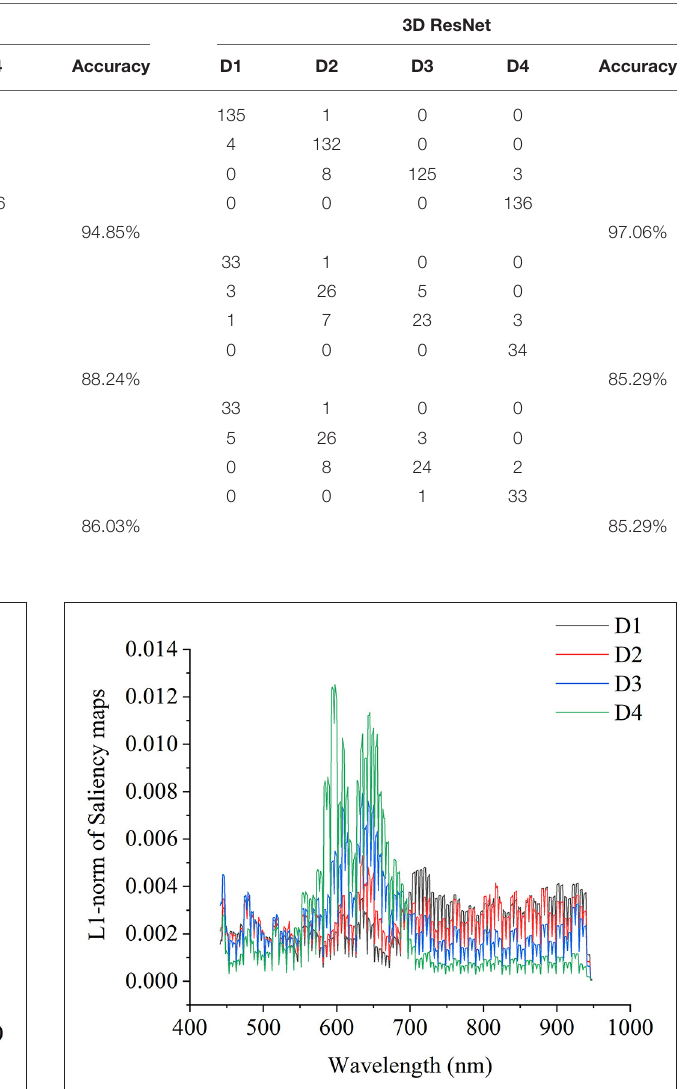
FIGURE 6 | Visualization of the wavelength contribution of the testing set by 3D